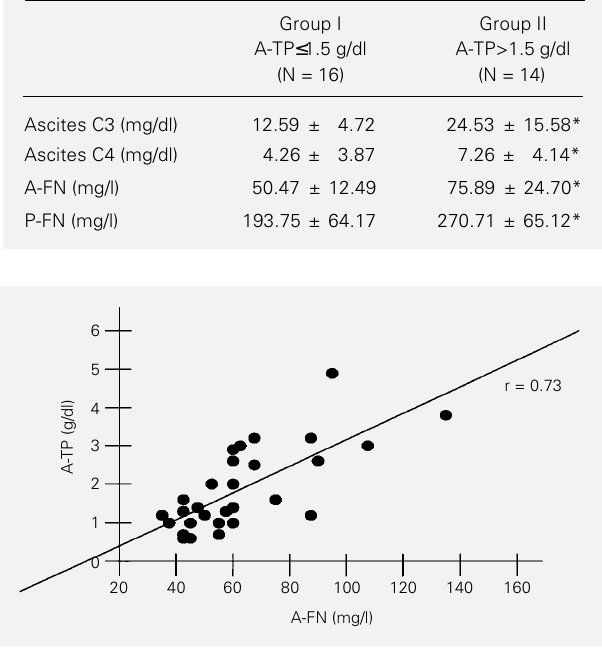
Figure 1 - Correlation between fibronectin (A-FN) and total protein (A-TP) in the ascitic fluid.